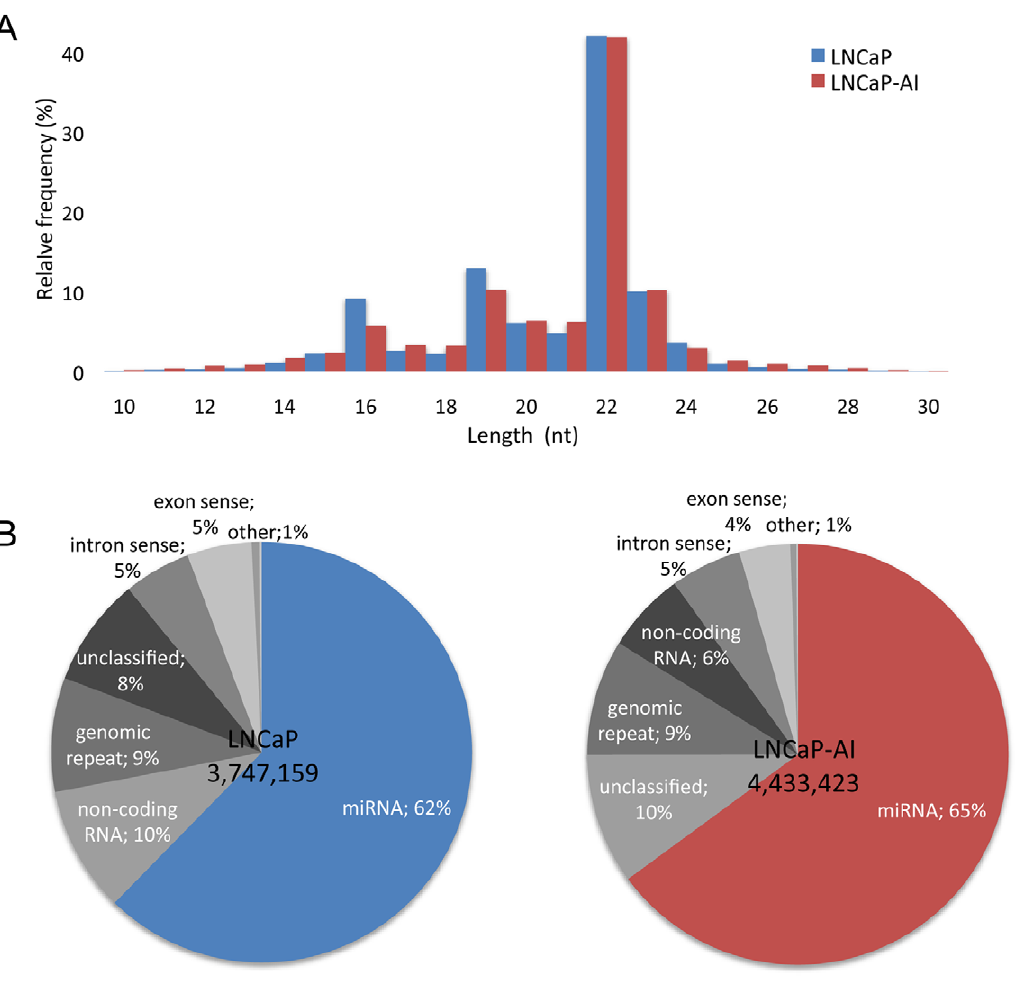
Figure 2. Size distribution and annotation of small RNAs from the libraries of LNCaP and LNCaP-AI. (A) Length distribution of sequenced reads. Both libraries accumulated 22-nucleotide small RNAs, which is consistent with the typical size of miRNAs. B) The proportions of various classes of small RNAs detected in LNCaP and LNCaP-AI. It is indicated that the majority of reads in both libraries belonging to the miRNA families.